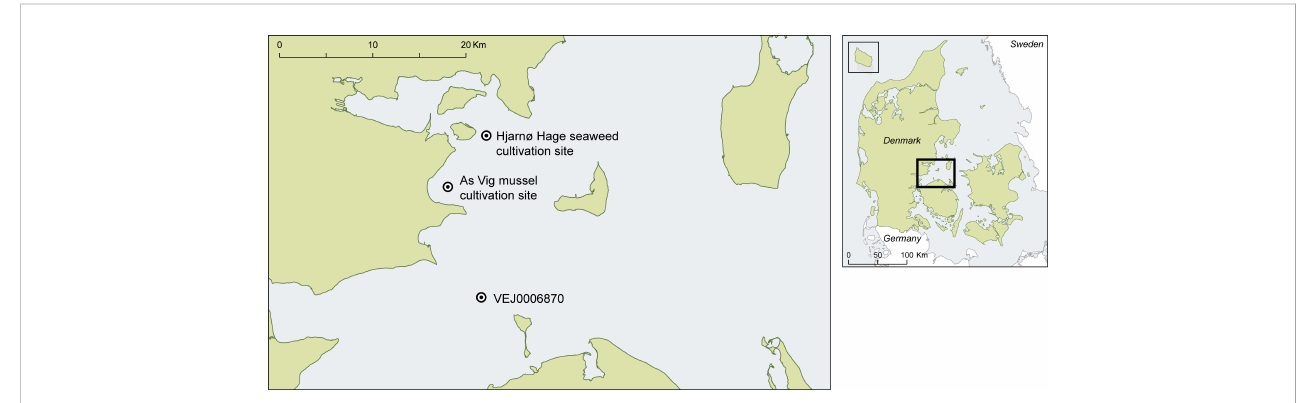
FIGURE 1 Location of the seaweed and mussel cultivation sites and the national environmental monitoring station, from where the environmental information was extracted (NOVANA station: